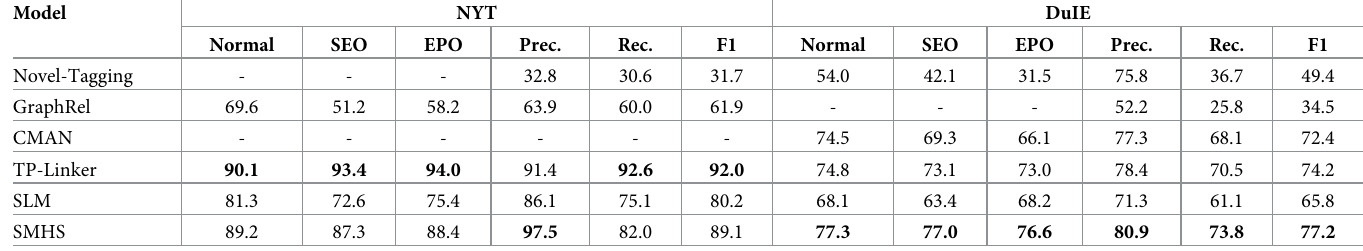
Table 3. Comparison of experimental results.